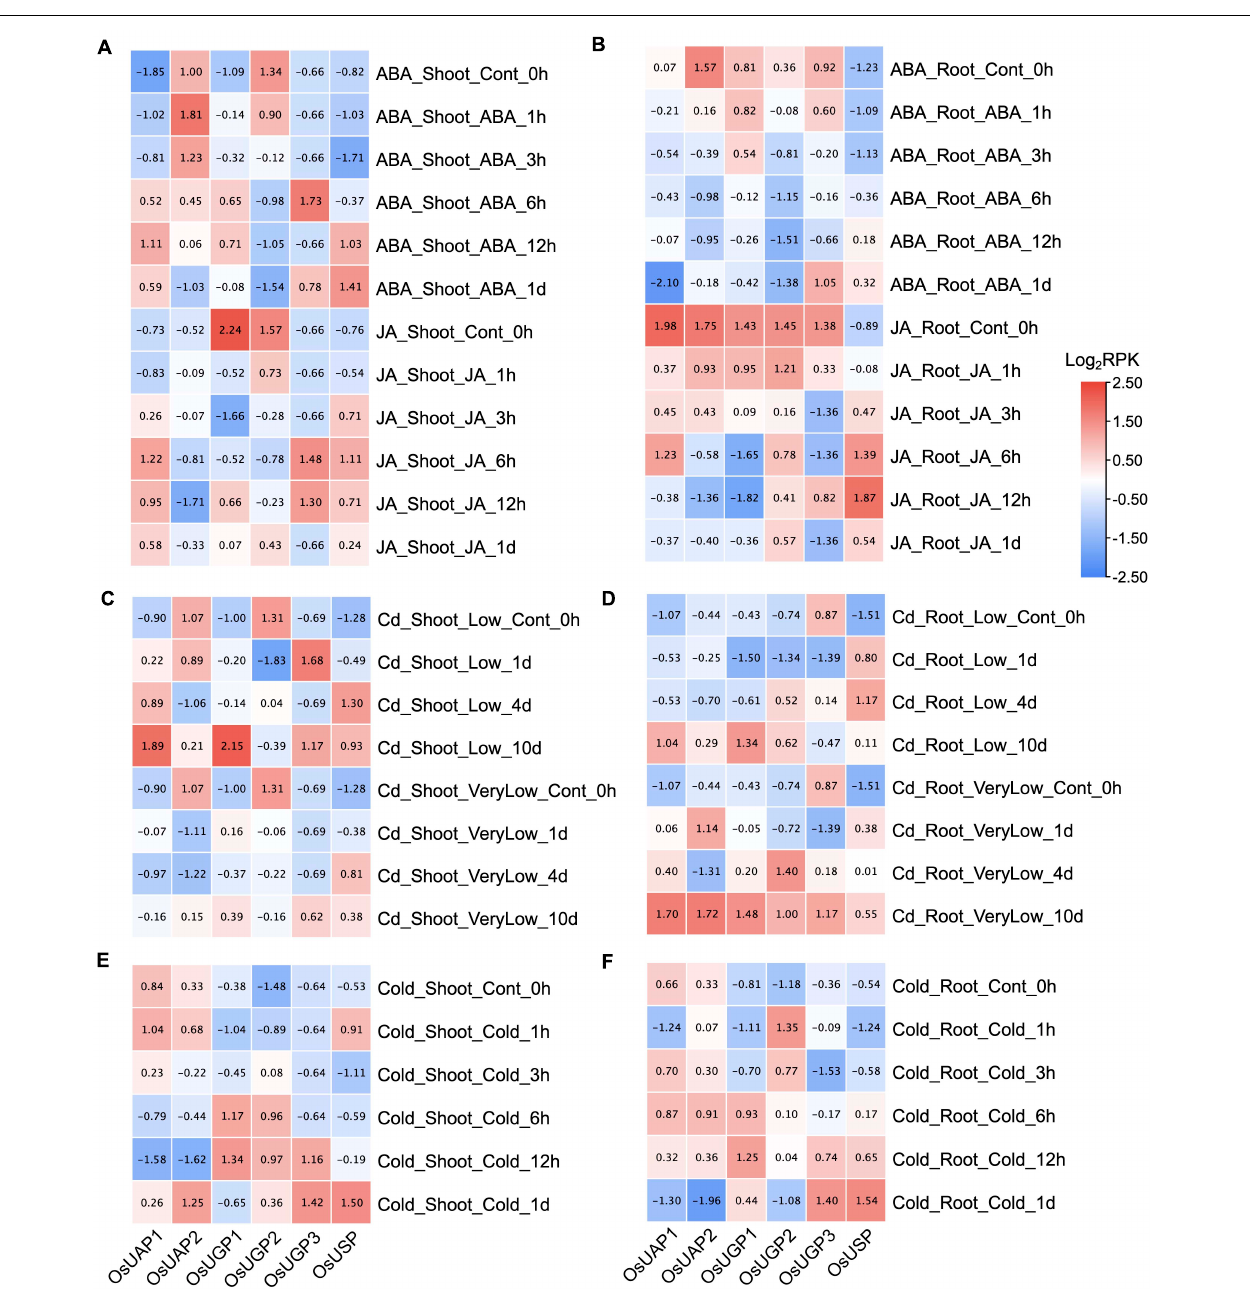
FIGURE 5 | (A–F) UDP glucose pyrophosphorylase (UDPGP) expression profiles under abscisic acid (ABA), jasmonic acid (JA), cadmium, and cold treatment. Transcriptional expression changes of UDPGPs in Oryza sativa shoot under ABA (100 µ M), JA (100 µ M), low cadmium (1 µ M CdSO 4 ), very low cadmium (0.2 µ M CdSO 4 ), and cold (4 ◦ C) treatment were downloaded from the TENOR database and displayed as filled blocks from red (upregulated) to blue (downregulated). The scale on the right indicates the gene expression level transformed by log 2 (RPK). All the genes were normalized by